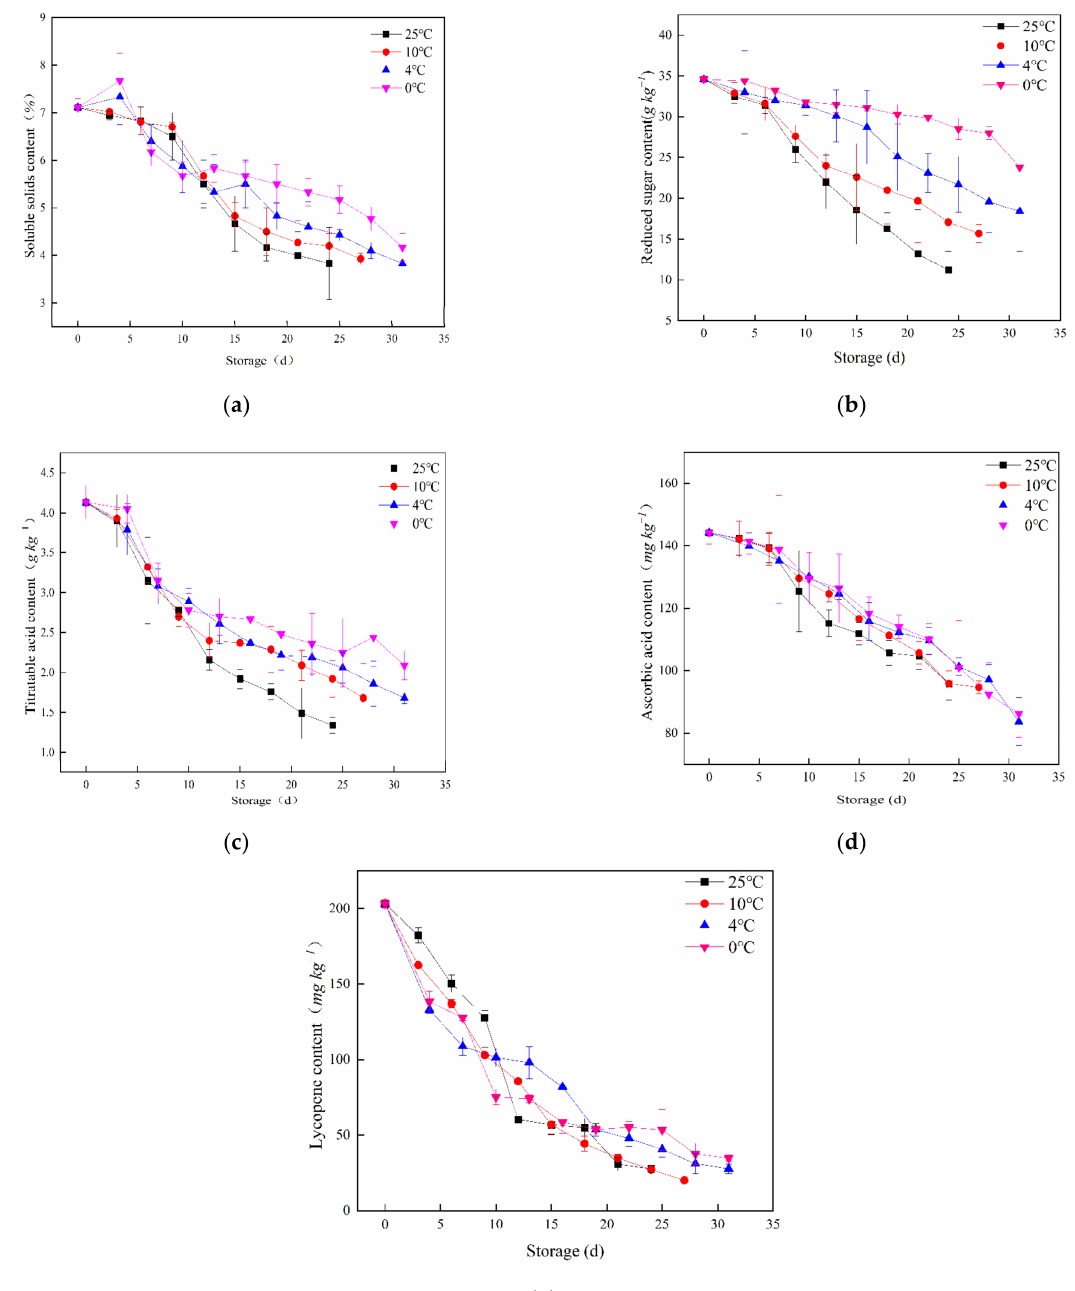
Figure 1. Changes in soluble solids content ( a ), reducing sugars ( b ), titratable acids ( c ), ascorbic acid ( d ) and lycopene ( e ) of cherry tomatoes during